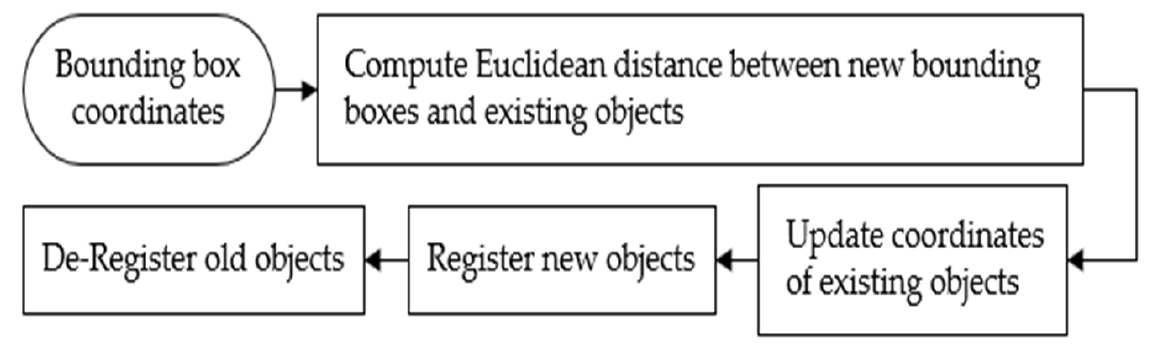
Figure 4. The schematic view of the vehicle detection and tracking algorithm. The first task in the vehicle detection and tracking phase is to identify the objects and build bounding boxes around them. For this purpose, all three bands (Red, Green, and Blue) of each frame of the video are normalized using the following equations (Equation (1)):